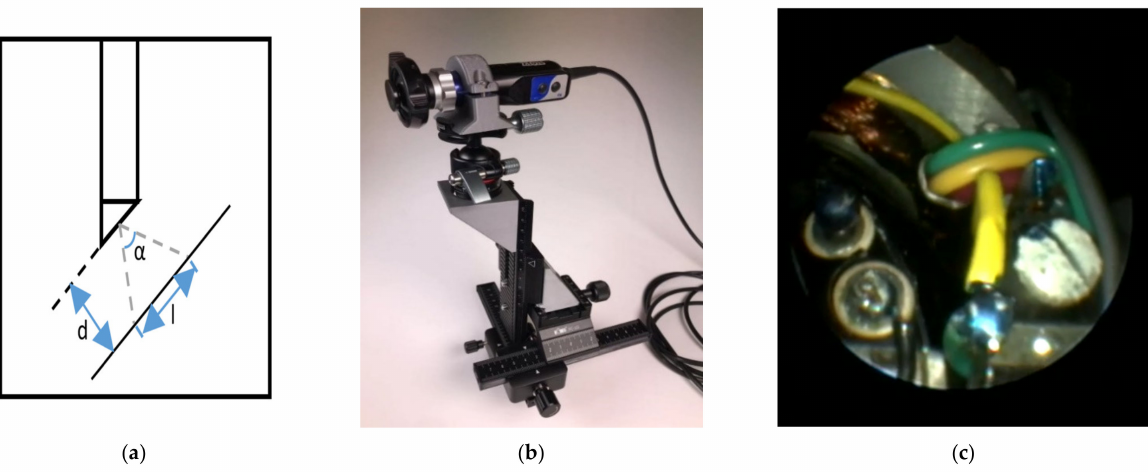
Figure 22. Endoscopic imagery: ( a ) opening angle; ( b ) mechanical gimbal set-up; and ( c )